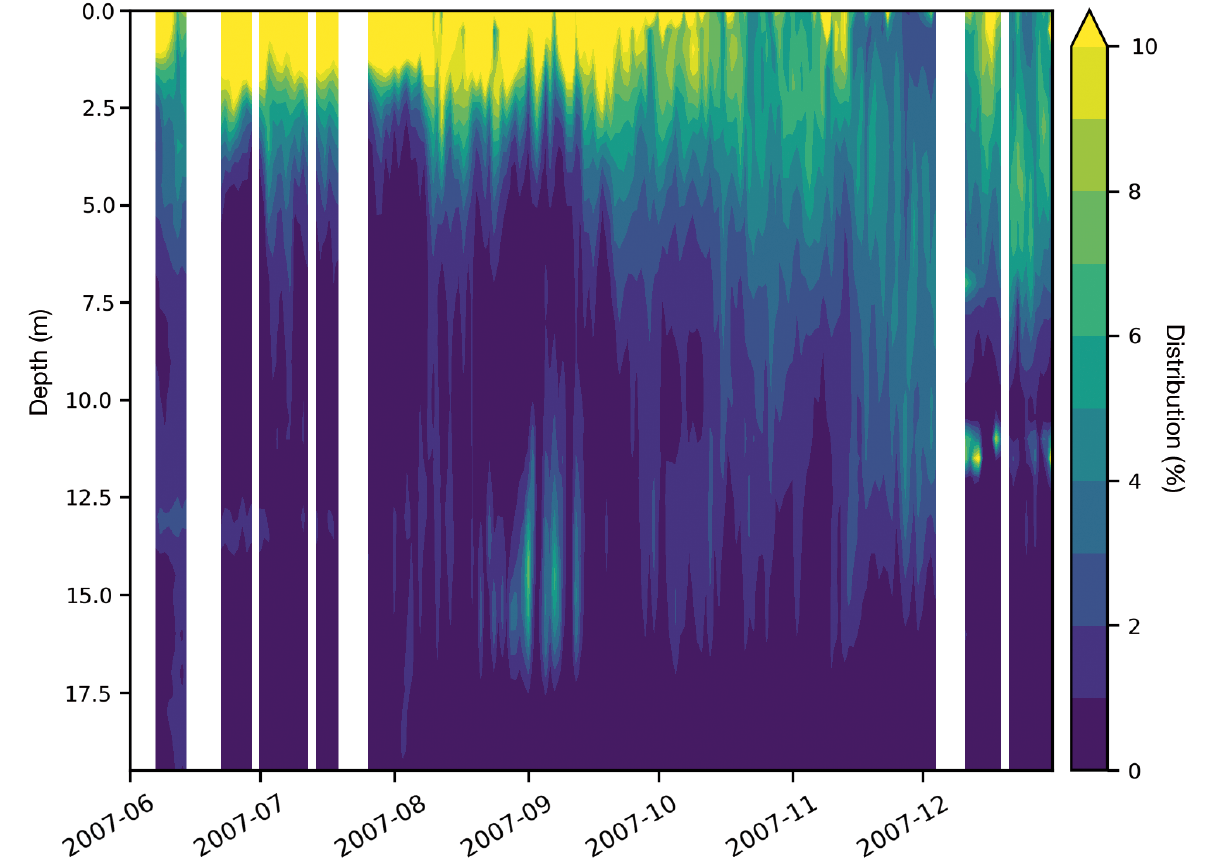
Fig. 4. Daily, relative vertical distribution of salmon observed at Langavika from June throughout December 2007 in 1 representative cage. White areas: data